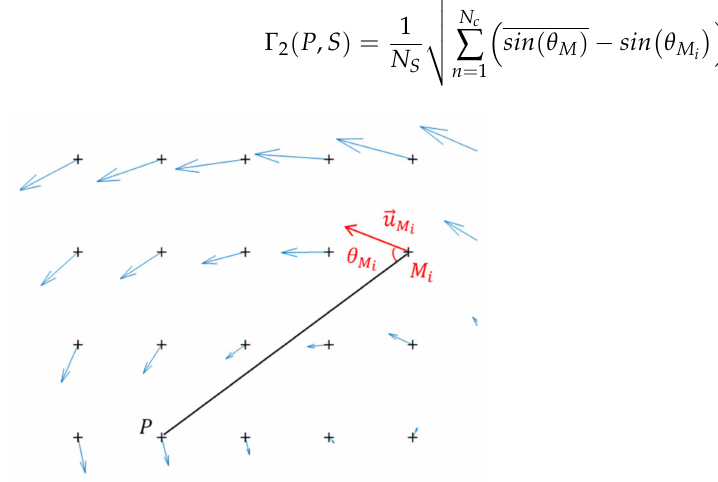
Figure 11. Center detection